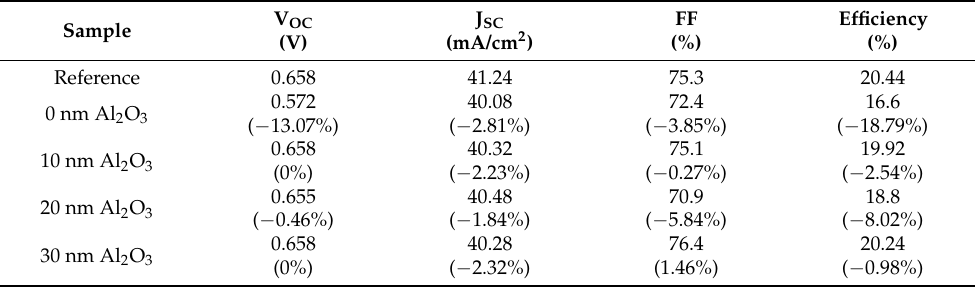
Table 1. Photovoltaic parameters with various Al 2 O 3 thicknesses after the accelerated PID test. The changes with respect to the values of reference sample are shown together in the